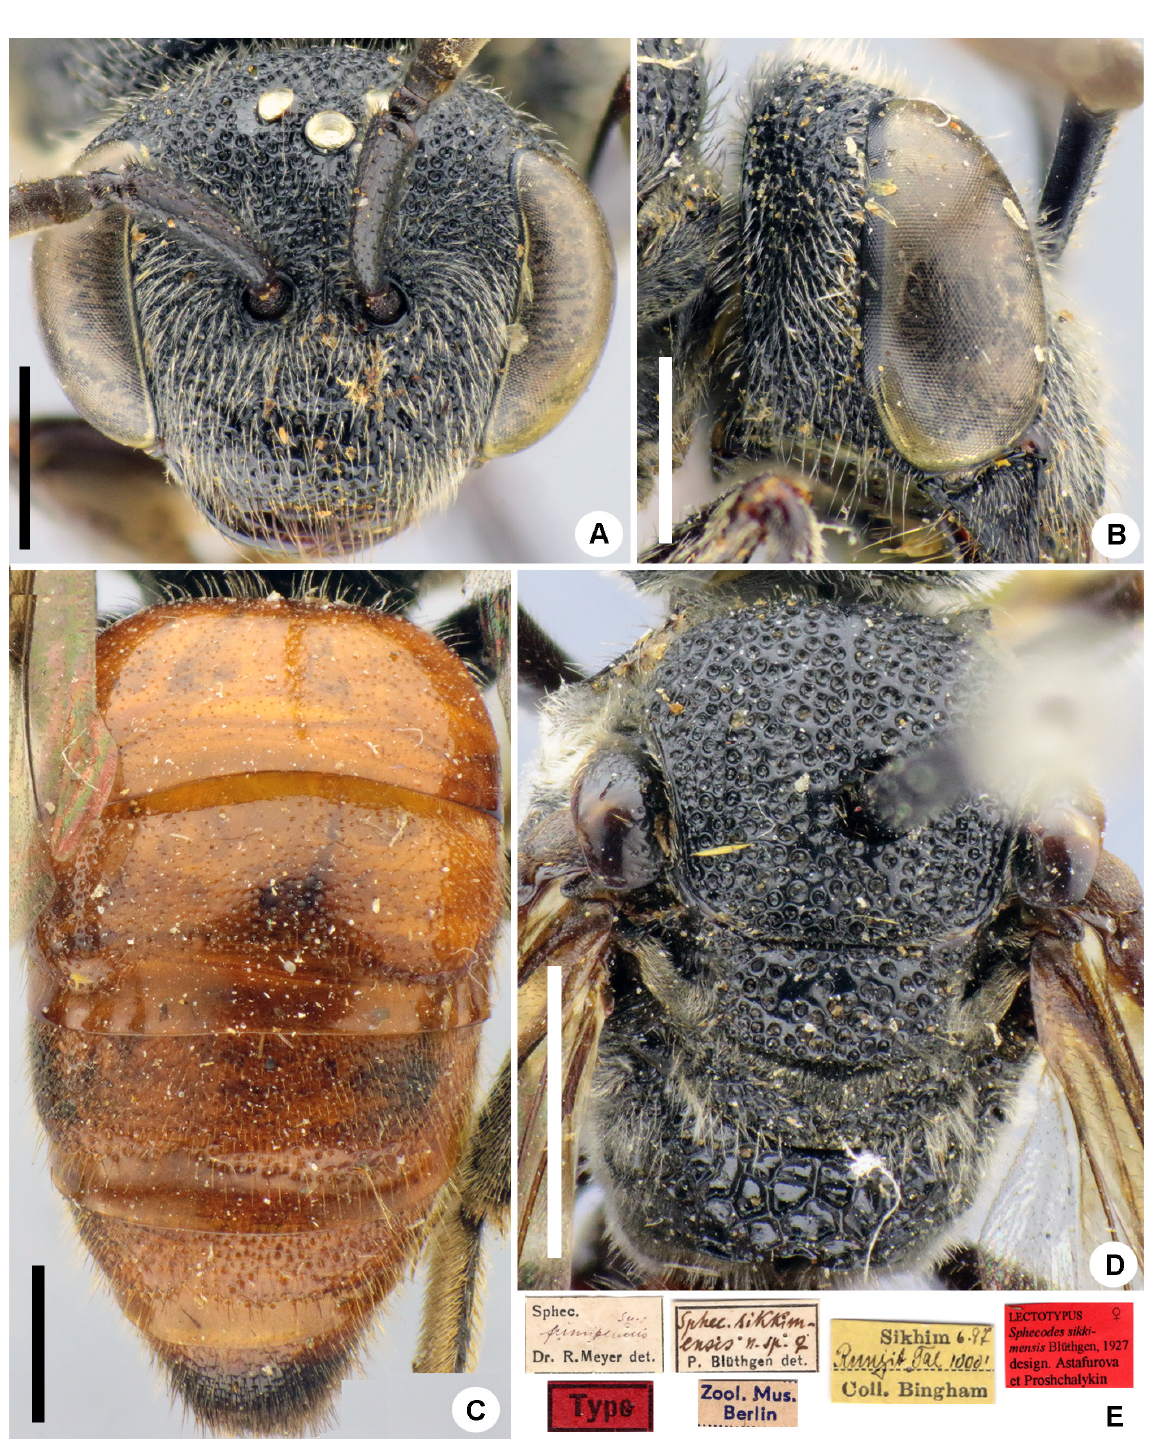
Fig. 18. Sphecodes sikkimensis Blüthgen, 1927. Lectotype, ♀ (ZMBH). A – B . Head in frontal (A) and lateral view (B). C . Metasoma in dorsal view. D . Propodeum in dorso-lateral view. E . Labels. Scale bars: A–C = 1 mm; D = 0.5